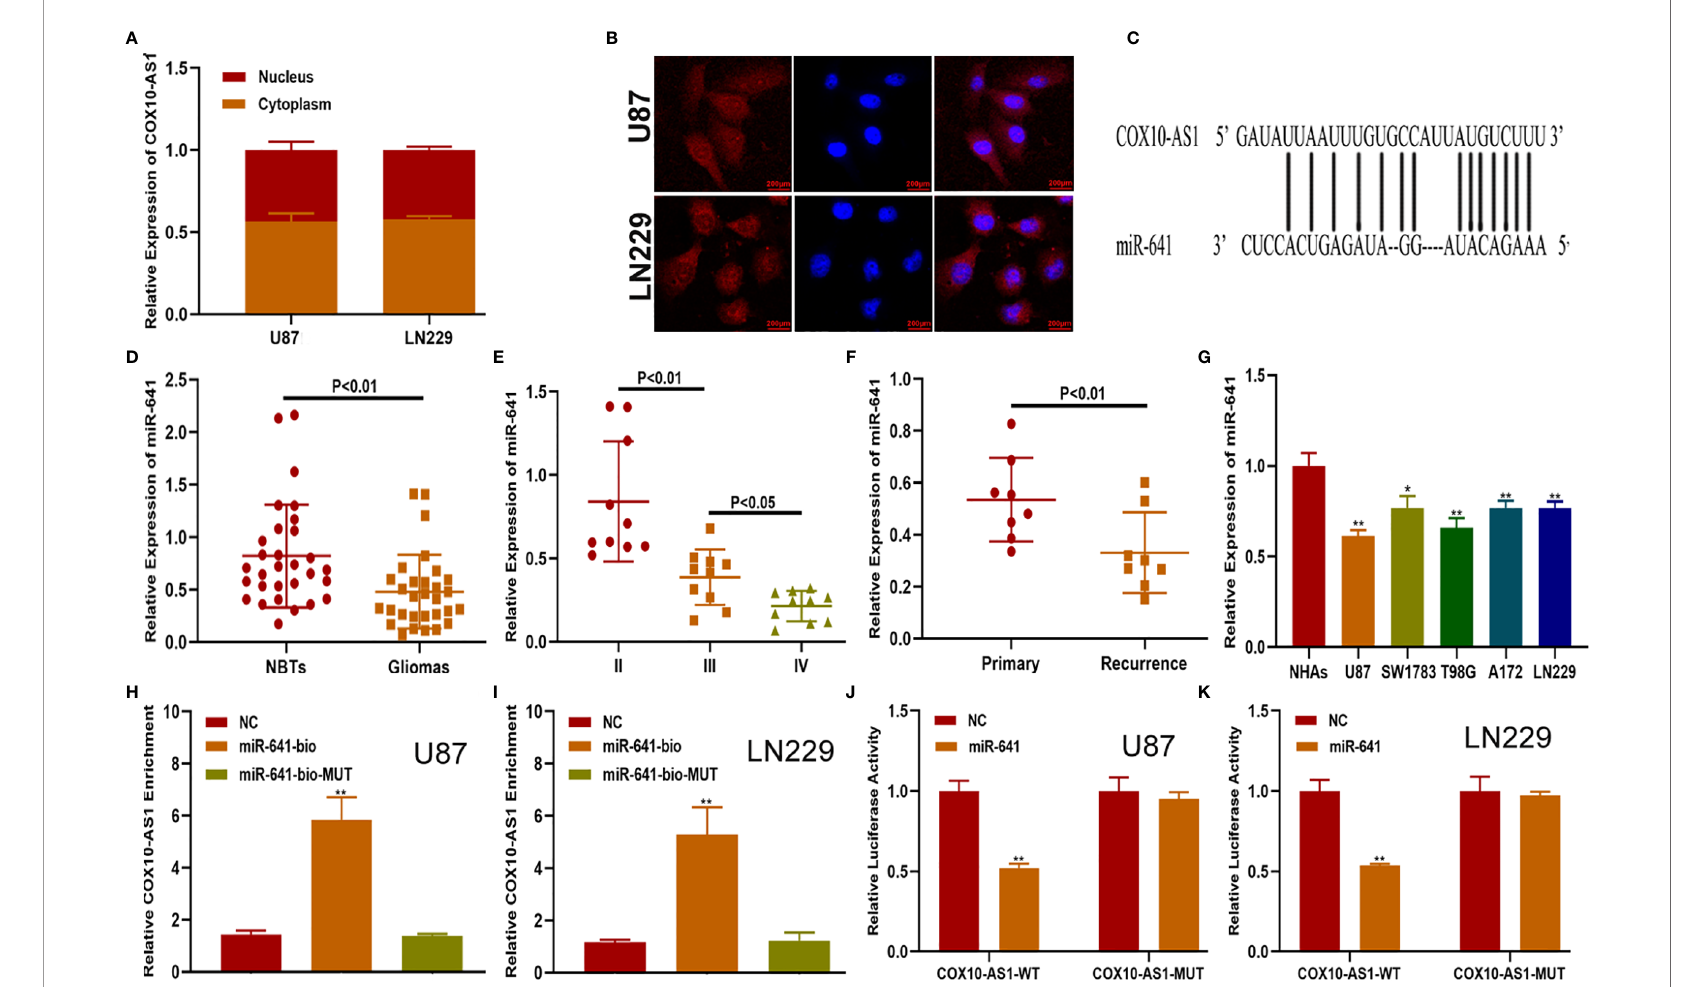
FIGURE 4 | COX10-AS1 acts as a sponge for miR-641. (A) RT-qPCR assays in nuclear and cytoplasmic RNA fractions detected the COX10-AS1 level in the cytoplasm and nucleus. (B) The distribution of COX10- AS1 in U87 and LN229 cells was evaluated by FISH assays. (C) The putative binding sites of miR-641 on COX10-AS1 were predicted by an online database. (D) The relative expression of miR-641 in clinical specimens. (E) The relative expression of miR-641 in different grade of glioma. (F) The relative expression of miR-641 in primary and recurrent glioma clinical specimens. (G) The relative expression of miR-641 in NHAs and glioma cell lines. (H, I) U87 and LN229 cells were assayed by biotin-based pull-down after transfection with biotin-labelled miR-641. (J, K) Luciferase reporter assay indicated that miR-641 reduced the luciferase activity of COX10-AS1-WT but not COX10-AS1-MUT. *P < 0.05, **P <